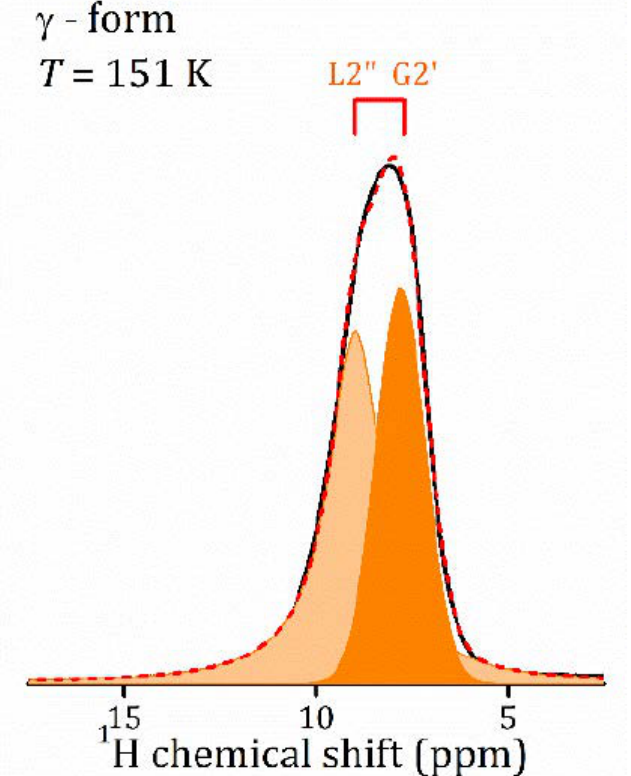
Figure 5. 1 H MAS NMR spectra at 151 K in γ -HCa 2 Nb 3 O 10 · y H 2 O and its